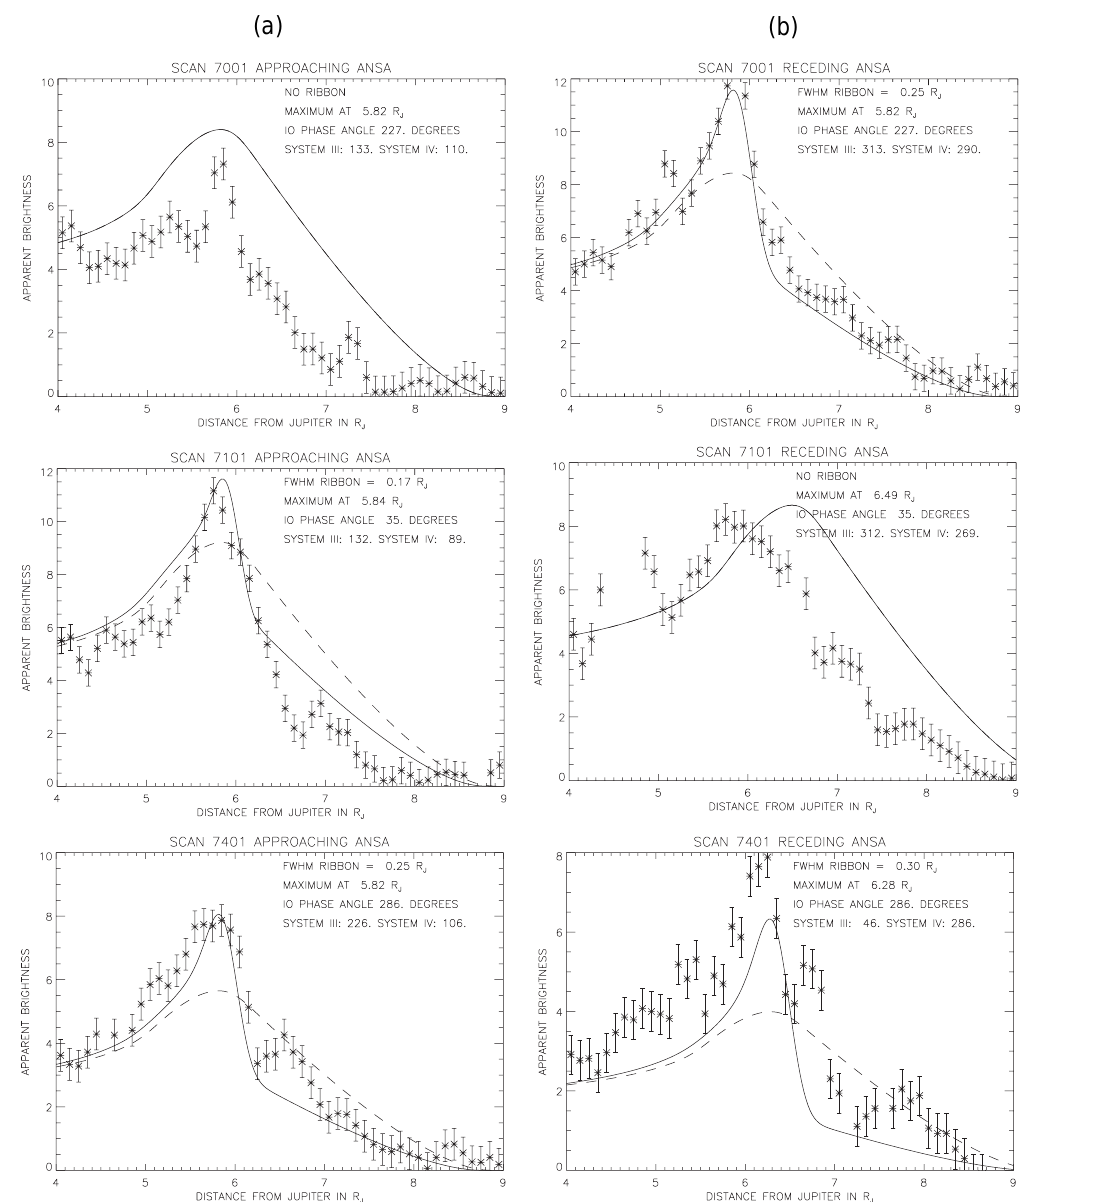
Figure 2. Three scans of the Io plasma torus on DOY 70, 71, and 74, divided into approaching (a) and receding (b) ansa. The dashed lines in the figure represent the brightness model by Sandel and Broadfoot (1982a) and the solid lines are with the ribbon feature included by Dessler and Sandel